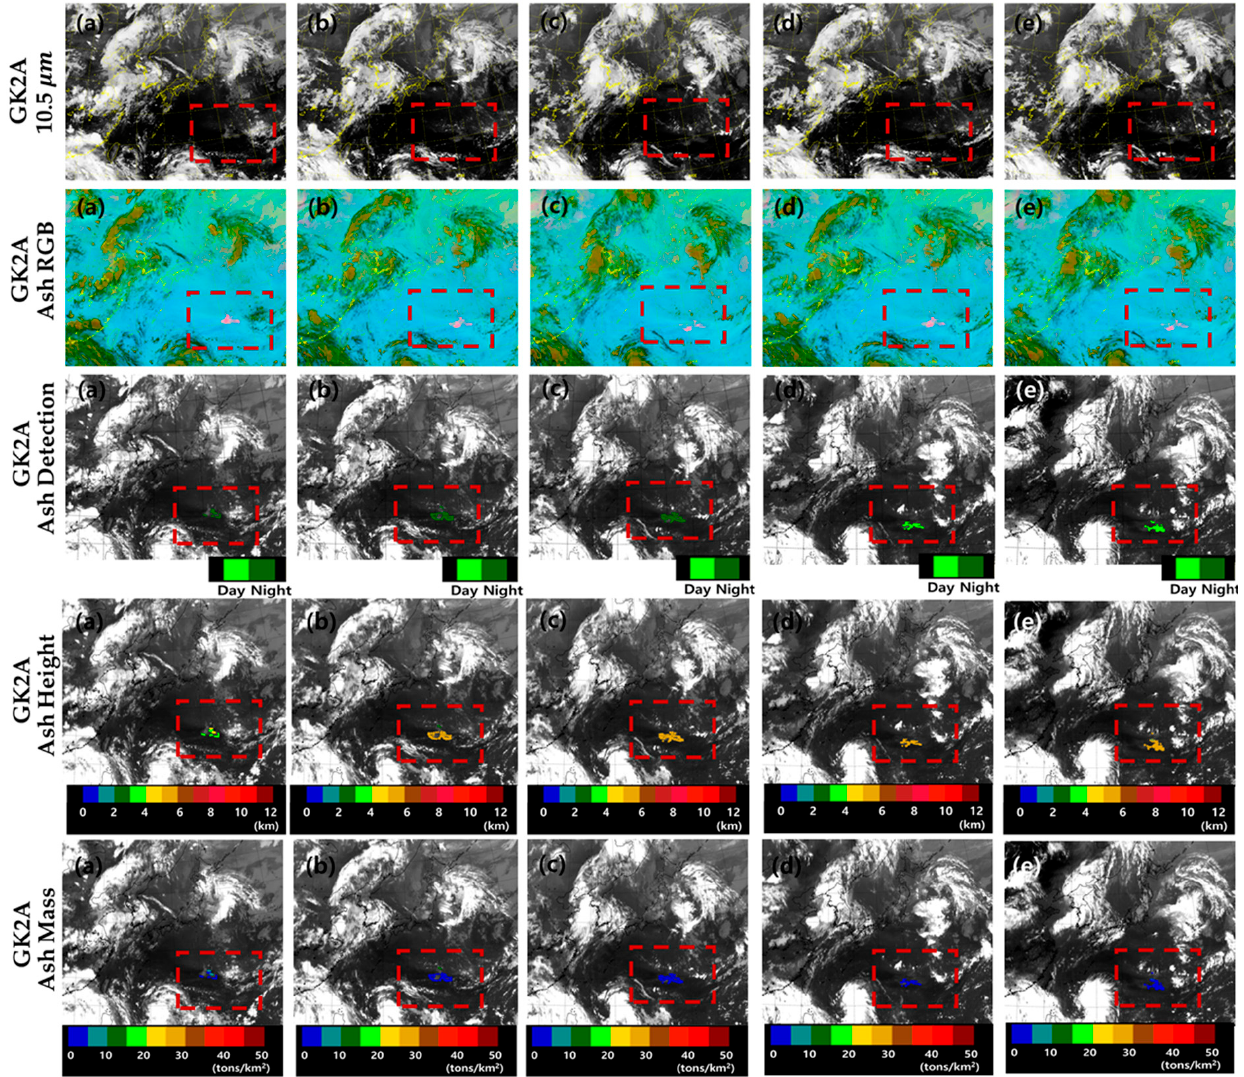
Figure 9. Images of the Nishinoshima volcano eruption (red dashed box) obtained on 31 July 2020, using GK-2A BT 10.5 µ m, GK-2A Ash RGB, GK-2A Volcanic Ash Detection (VAD), GK-2A Volcanic Ash Height (VAH), and GK-2A Volcanic Ash Mass (VAM) at ( a ) 12:00 UTC ( b ) 16:00 UTC ( c ) 20:00 UTC and on 1 August 2020, at ( d ) 00:00 UTC ( e ) 04:00 UTC. The image boundary is a rectangular region (latitude 18° N–47° N and longitude 112° E–155° E; Japan Expansion Area).